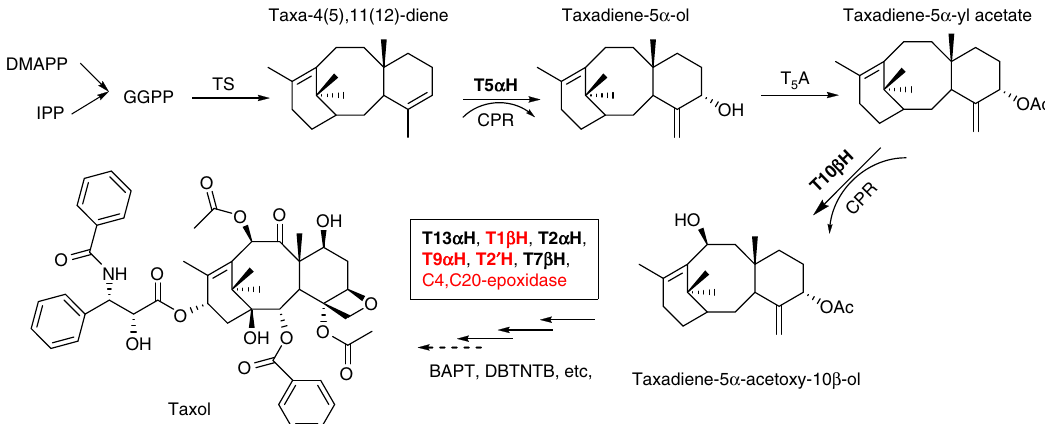
Fig. 1 Scheme of Taxol biosynthesis. DMAPP, dimethylallyl diphosphate; IPP, isopentenyl diphosphate; GGPP, geranylgeranyl diphosphate; TS, taxadiene synthase; T5 α H, taxadiene-5 α -hydroxylase; CPR, cytochrome P450 reductase; T5A, taxadien-5 α -ol-O-acetyltransferase; T10 β H, taxane-10 β -hydroxylase; T13 α H, taxane-13 α -hydroxylase; T1 β H, taxane-1 β -hydroxylase; T2 α H, taxane-2 α -hydroxylase; T9 α H, taxane-9 α -hydroxylase; T2 ′ H, taxane-2 ′ -hydroxylase; T7 β H, taxane-7 β -hydroxylase; BAPT, Baccatin III-3-amino, 13-phenyl-proanoyl-CoA transferase; DBTNBT, 3 ′ -N-debenzoyltaxol-N-benzoyltransferase. P450 genes are marked in bold and unknown P450 genes are marked in